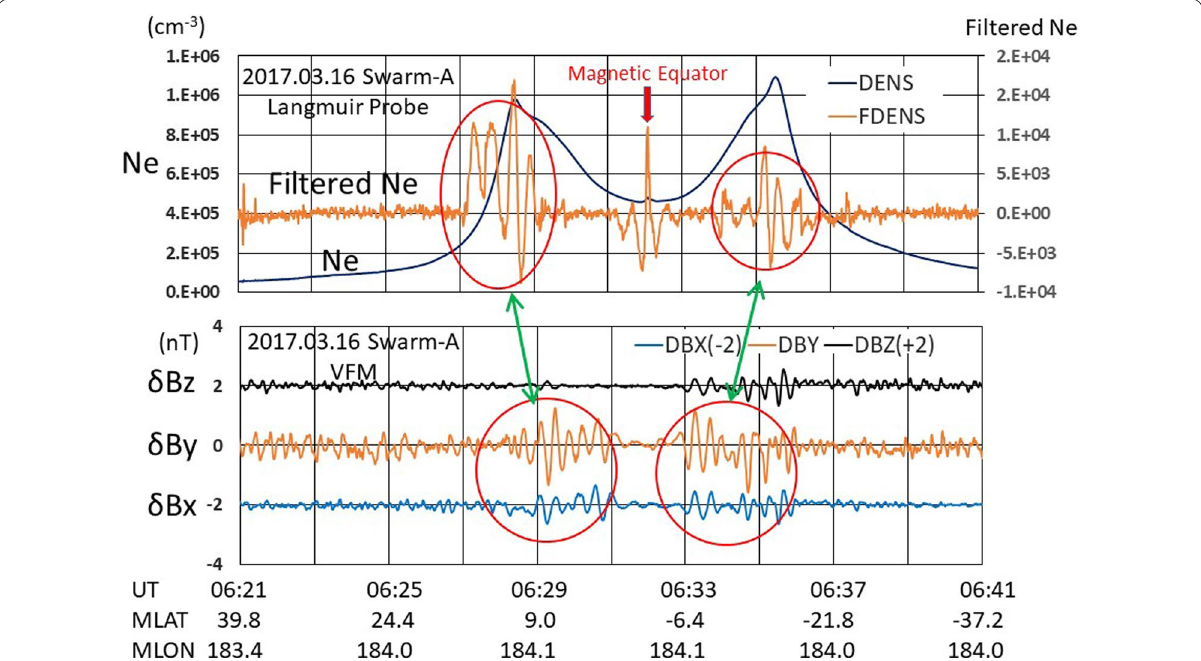
Fig. 2 An example of electron density and its fluctuations (upper panel) and magnetic ripples (lower panel) in sensor coordinate system (approximately, x: upward or downward, y: eastward or westward, z: satellite velocity direction). MLAT and MLON are dipole latitude and longitude,